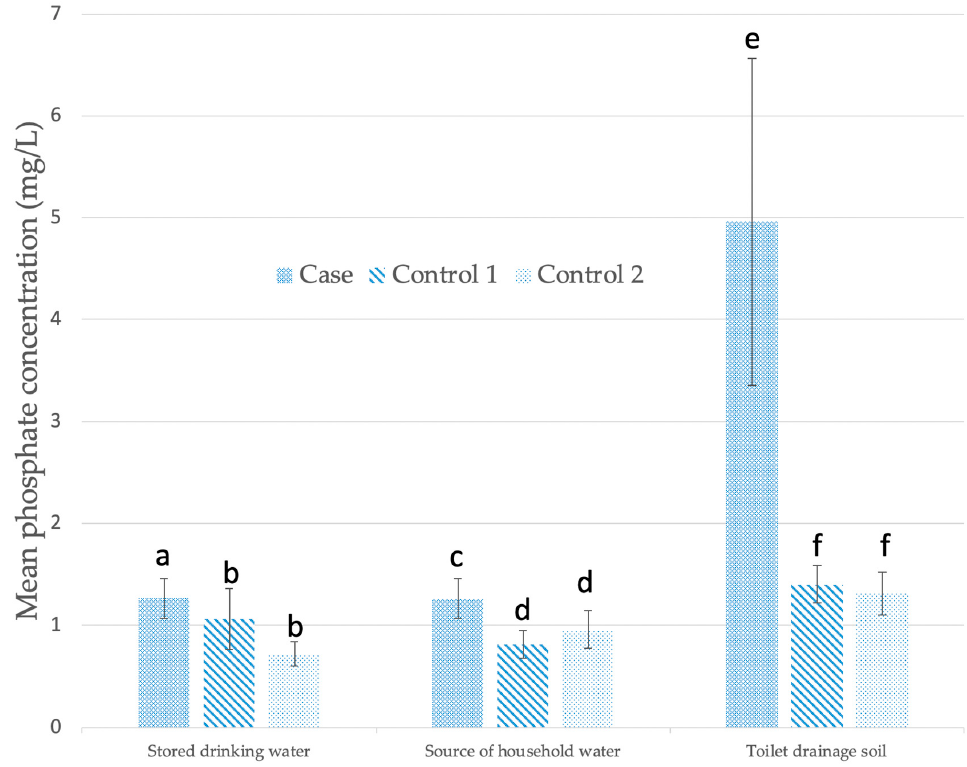
Figure 4. Mean concentration of phosphates in water and soil in the residential setting of cases and controls. error bars = +/ − standard error. Within each set of columns, sequential lettering indicates significant di ff